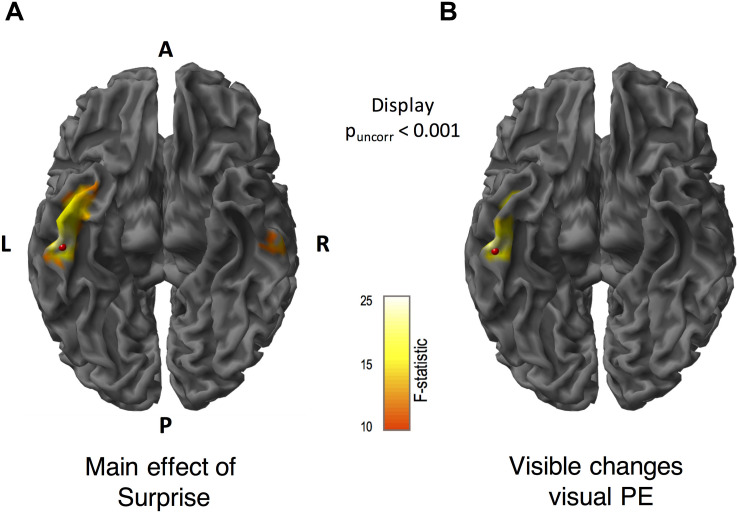
Source reconstructed F-statistics for the main effect of surprise, and prediction errors (PE) to visible motion direction changes. We obtained source locations using multiple sparse priors (MSP) source reconstruction. These maps are displayed at puncorr < 0.001. (A) For the main effect of surprise, we found a significant cluster in the left inferior temporal gyrus. (The cluster in the right inferior temporal gyrus did not survive after correction). (B) Source localization for visible motion changes revealed a significant cluster in the left inferior temporal gyrus. The F-statistic is displayed for all contrasts within the range of 10 to 25, where F = 12.11 corresponds to p < 0.05 FWE corrected. A = anterior, P = posterior, L = left and R = right. Red beads indicate the location of the peak of F-statistic.